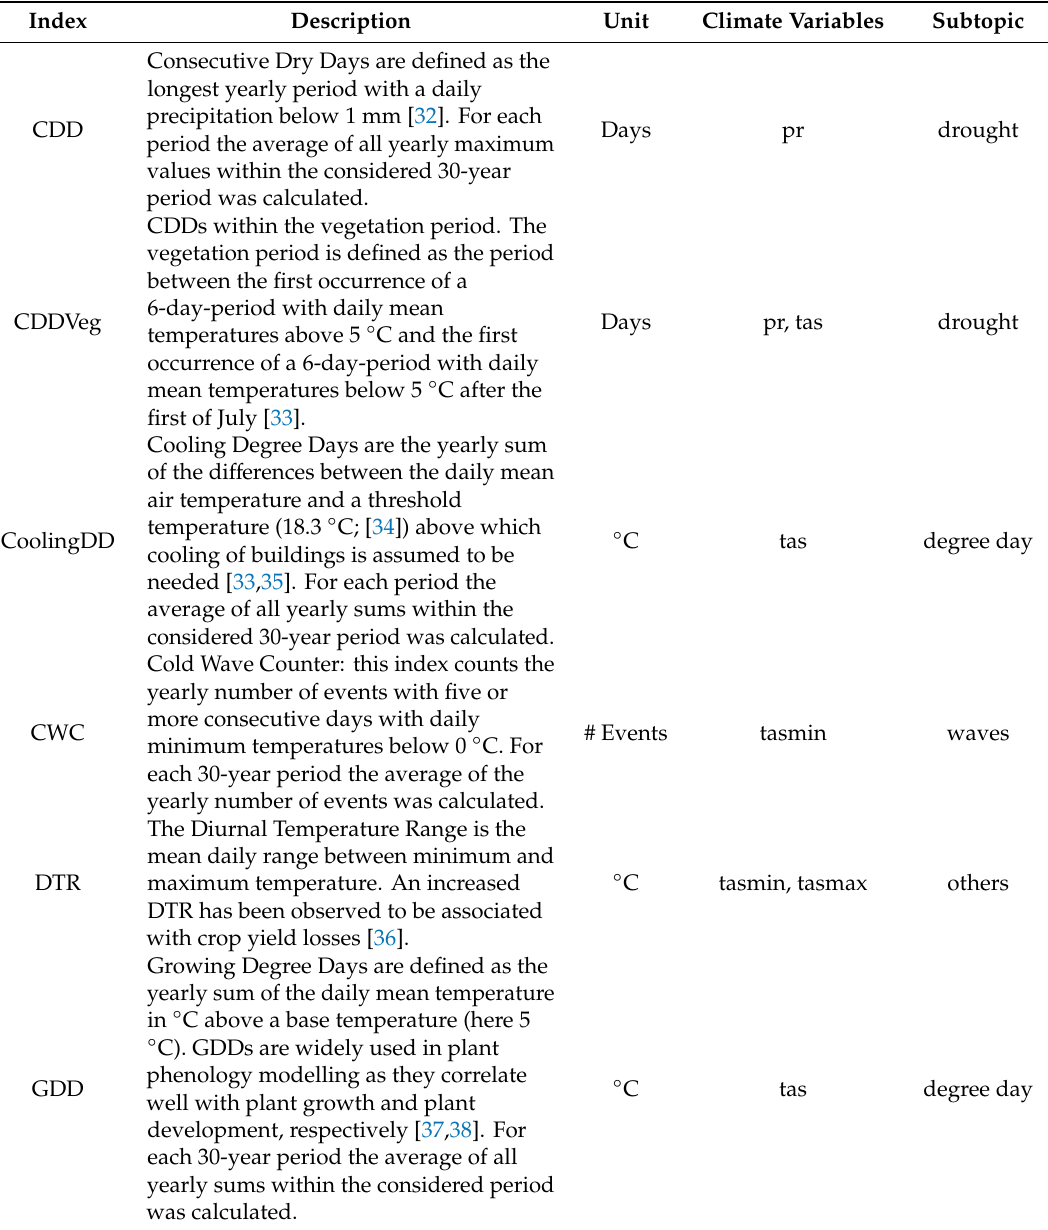
Table 1. Description and definition of the indices used in this study with the corresponding unit, subtopic and the required climate variables (daily mean temperature (tas), daily minimum temperature (tasmin), daily maximum temperature (tasmax), precipitation (pr) and global radiation